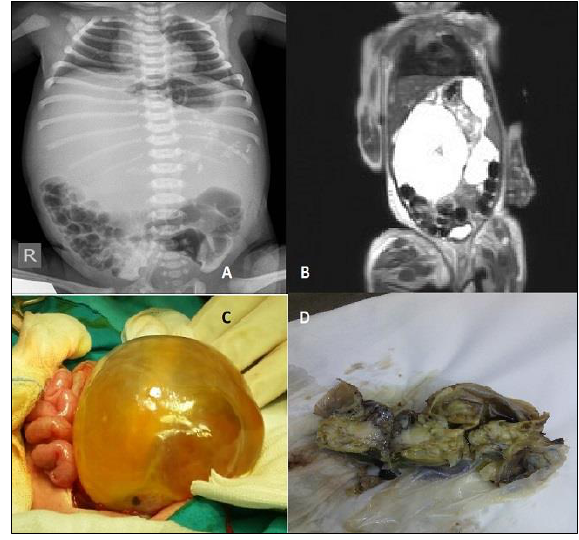
Figure 1: A) X-ray abdomen showing mass effect and calcifications. B) MRI abdomen showing huge mass mostly cystic with displacement of surrounding structures. C) peroperative picture. D) Gross specimen showing cartilagenous